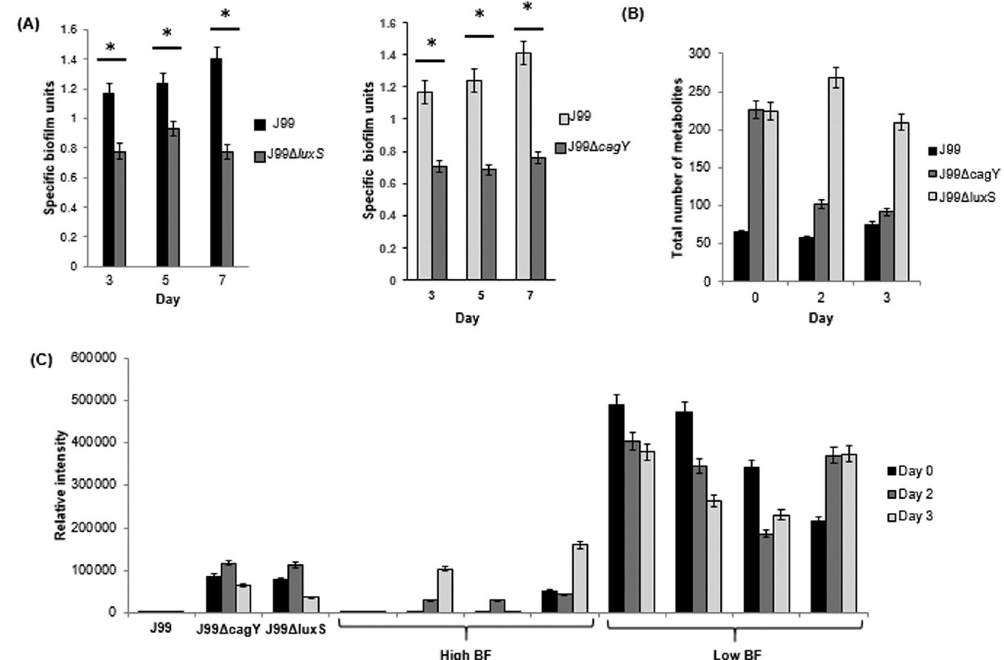
Figure 4. ( A ) Specific biofilm unit of wild-type H. pylori J99, J99 Δ luxS and J99 Δ cagY determined by crystal violet assay. ( B ) Comparison of number of metabolites detected by LC-MS per sample for H. pylori J99, J99 Δ luxS and J99 Δ cagY . * Represents p-value < 0.05 comparing between wild-type and mutants. ( C ) Comparing the relative abundance of PI-Cer(t18:0/18:0(2OH)) in H. pylori J99, J99 Δ luxS , J99 Δ cagY ,